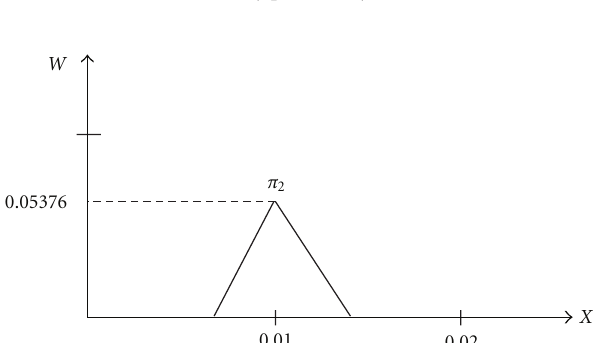
Figure 9: Fuzzy probability number π 4 .